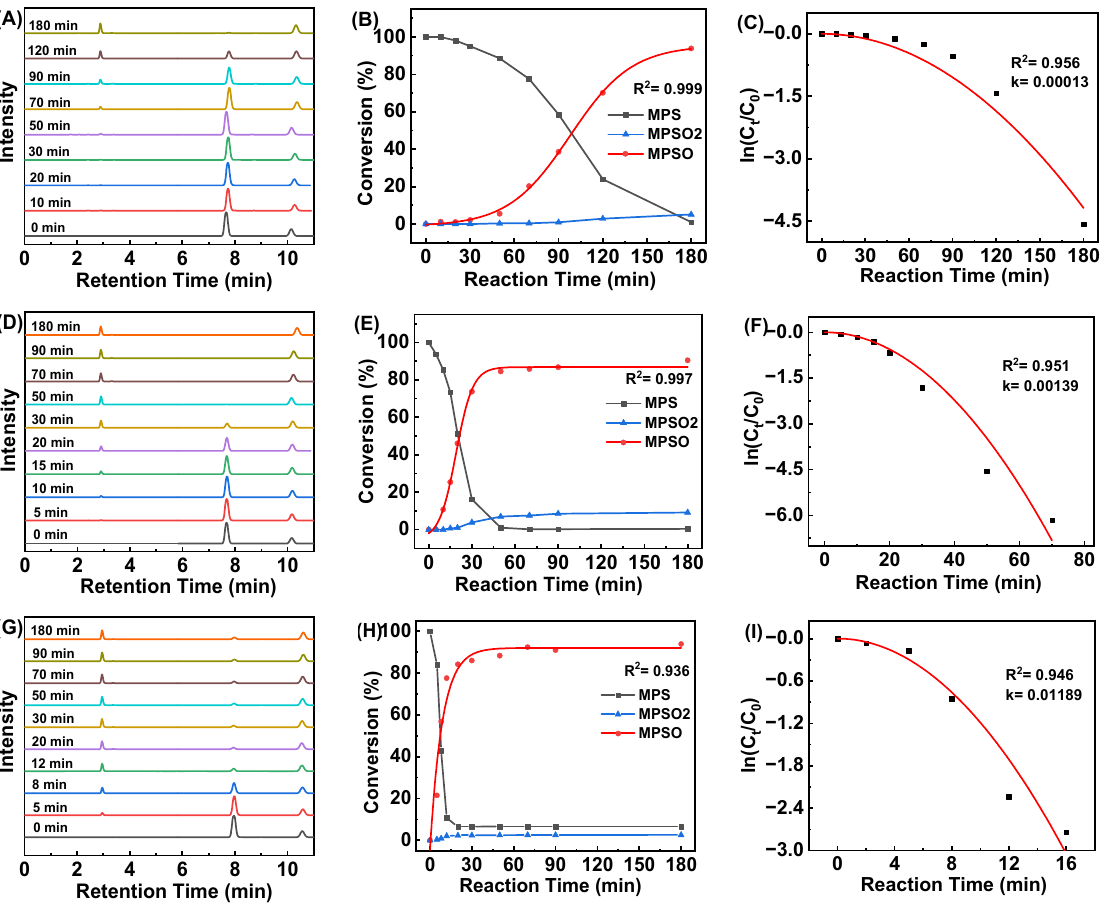
Figure 4. HPLC, conversion, and kinetics curves during the catalytic oxidation of MPS by 1/400 eq of HCCP-V and 1.2 eq of H 2 O 2 at different temperatures: ( A – C ) 25 °C, ( D – F ) 40 °C, and ( G – I ) 55 °C. Naphthalene with a retention time of 10.2 min was used as an internal standard.